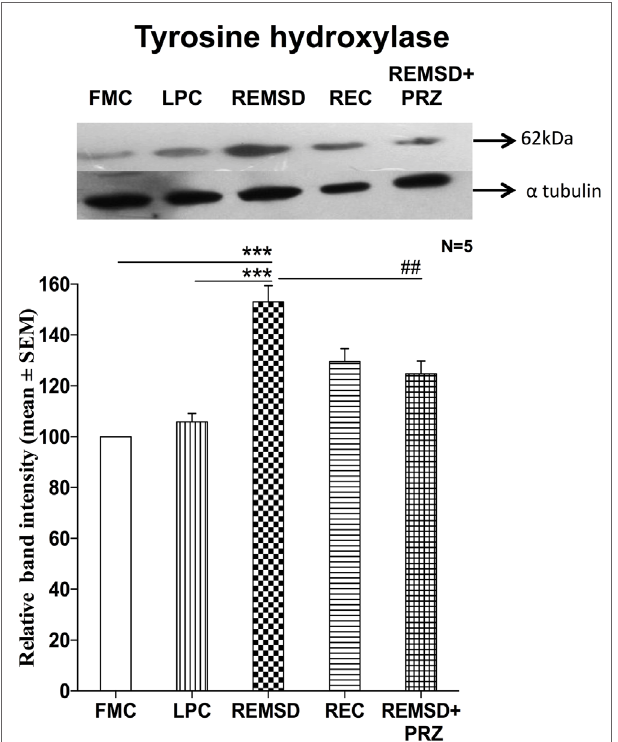
FigUre 9 | Tyrosine hydroxylase expression in the brain homogenate of rats maintained under different conditions . Upper panel shows a representative Western blot of tyrosine hydroxylase. Histogram in the lower panel shows percent changes in the mean ( ± SEM) band densities of the blots as compared to FMC taken as 100% in five sets of experiments. Abbreviations are as in the text. Significance levels are between the treatments of connecting horizontal bars; *** p < 0.001 and # p < 0.05, * as compared to FMC and # as compared to